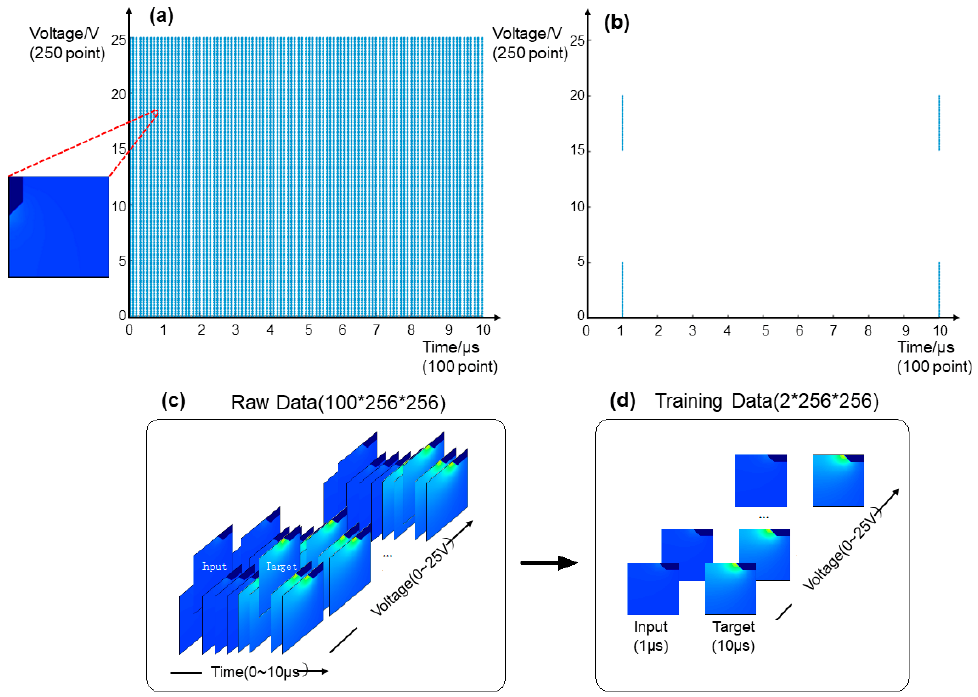
Figure 2. ( a ) A schematic of the raw dataset of a simulation result. The dataset contained 250 voltage results with 100 temperature distributions at different times per voltage ( b ) A schematic of training data of simulation result, 100 data at 1 µs as input data, and another 100 data at 10 µs as target data ( c ) surface temperature distribution of raw data, ( d ) surface temperature distribution of training data.